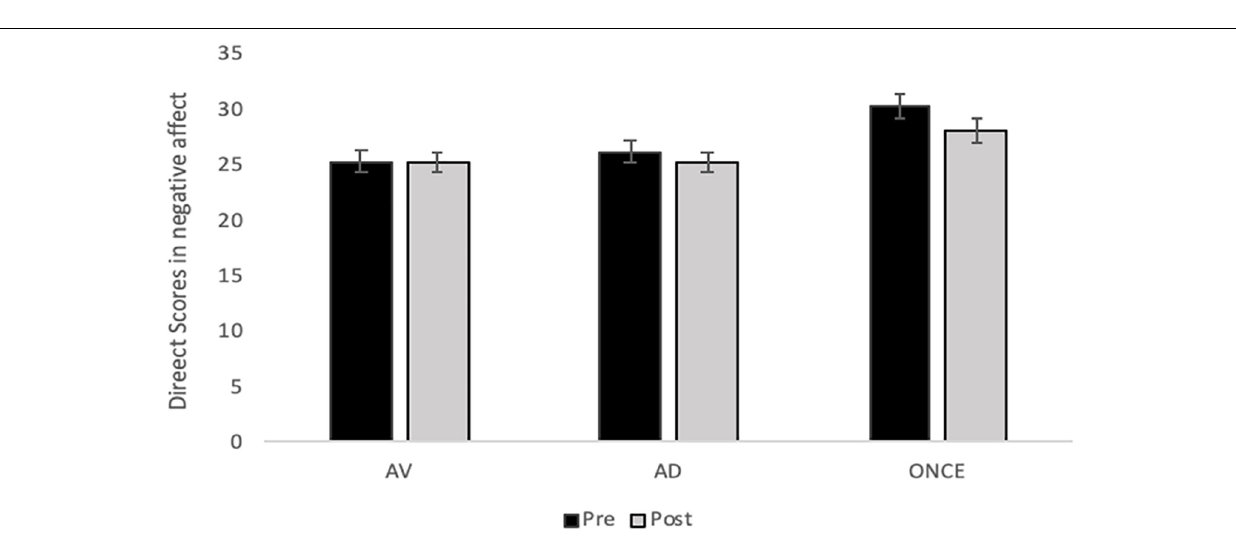
FIGURE 4 | Estimated Means of Negative Affect for each phase (Pre and Post-Task) across the three groups. Error bars represent standard error of the mean